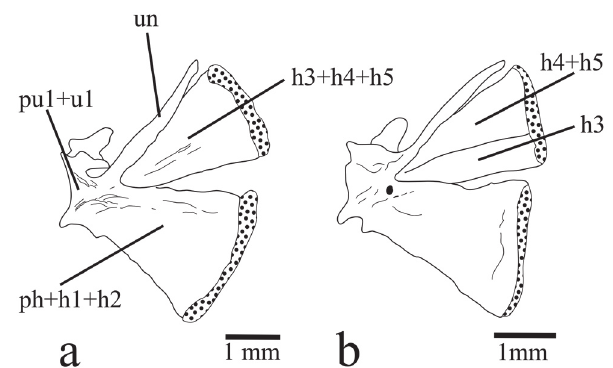
Fig. 3. Caudal skeleton (caudal-fin rays not illustrated) of: a. Trichomycterus steindachneri (MBUCV-V-35652), paratype, 86.7 mm SL. b. T. cachiraensis (MBUCV-V-35384), paratype, 74.9 mm SL. Left lateral view. Abbreviations: h1-5, hypurals 1 to 5; ph, parhypural; pu1+u1, compound caudal centrum (preural centrum 1 plus ural centrum 1); un, uroneural.